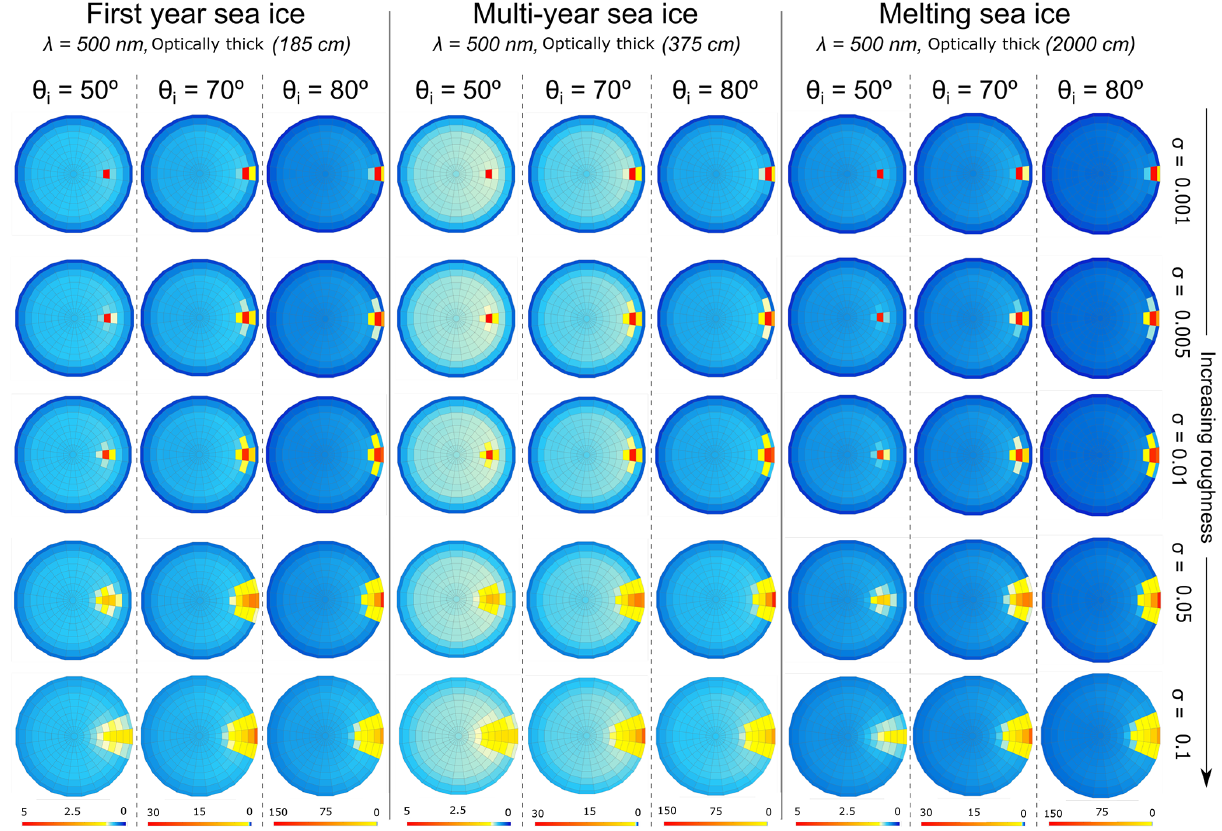
Figure 7. CCRF of optically thick first-year sea ice, multi-year sea ice and melting sea ice with an increasing surface roughness at λ = 500nm. The incident angles are θ i = 50 ◦ , θ i = 70 ◦ and θ i = 80 ◦ . Note that the scale of the colour bar varies for the different illumination angles in order to visualise clearly the BRF